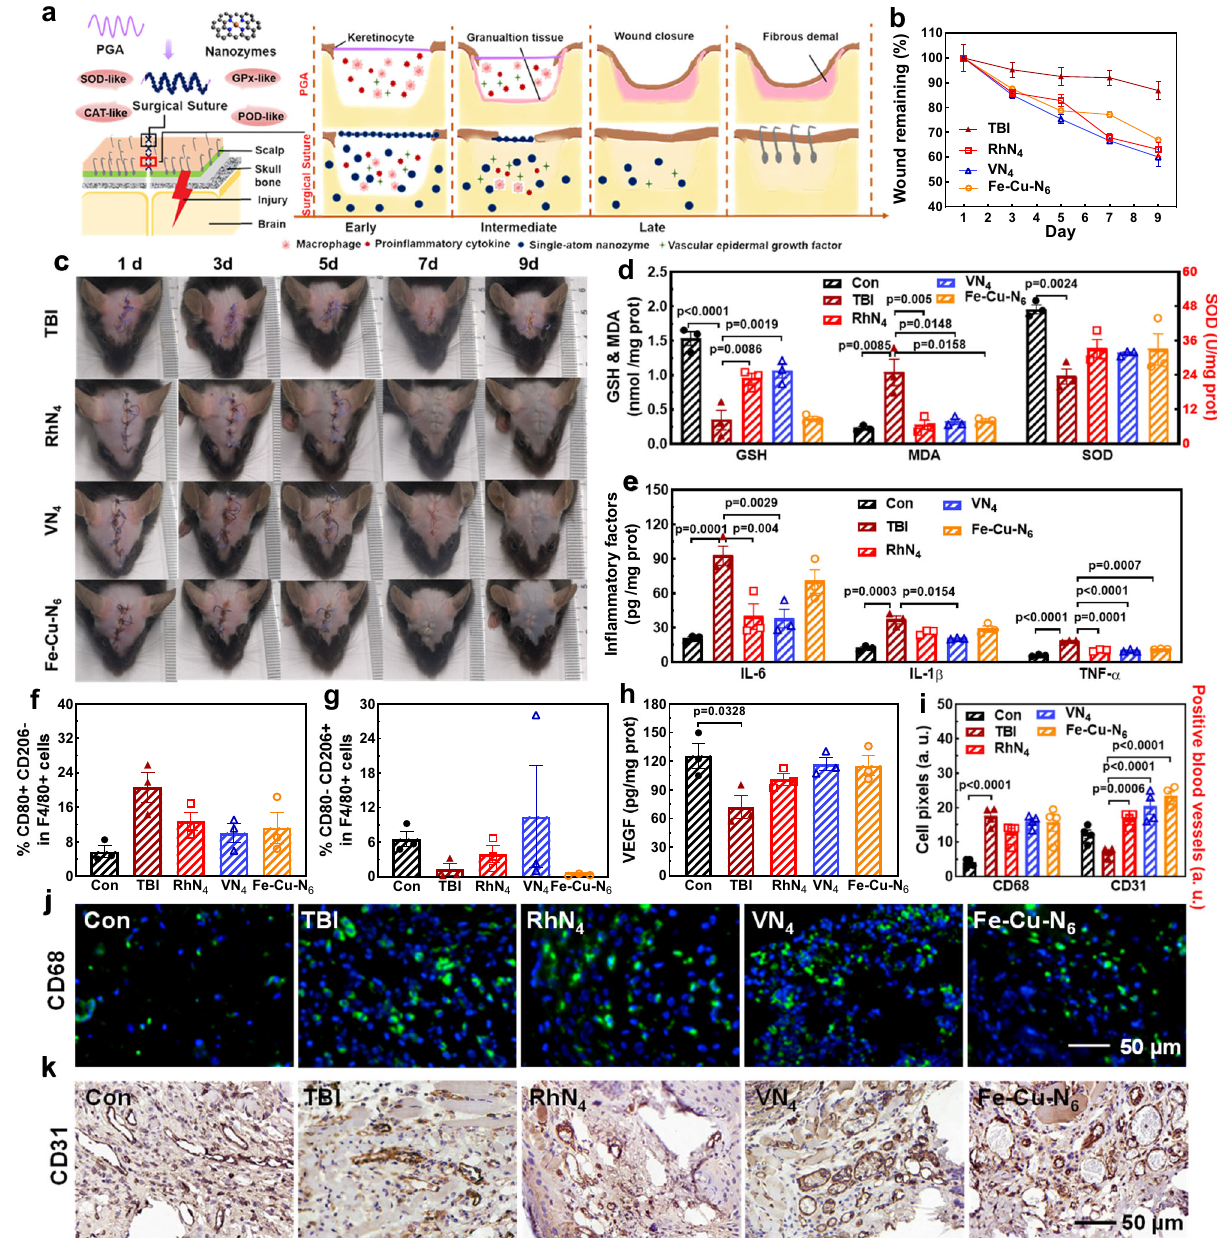
Fig. 6 | The scalp healing process with MN x sutures. a Schematic illustration of the scalp closure process modulated by MN x sutures. b , c Representative residual wound ( b ) and photographs of scalp healing ( c ) over time with and without MN x sutures( n =3images/3mice). d Indicatorsforoxidativestressofthescalponday3 post injury ( n =3 biologically independent samples). e ELISA analysis of IL-6, IL-1 β and TNF- α levels in scalp with or without MN x sutures on day 3 post-injury ( n =3 biologically independent samples). f , g The fl ow cytometry analysis of f M1 and g M2 macrophages in the scalp after treatments ( n =3 biologically independent